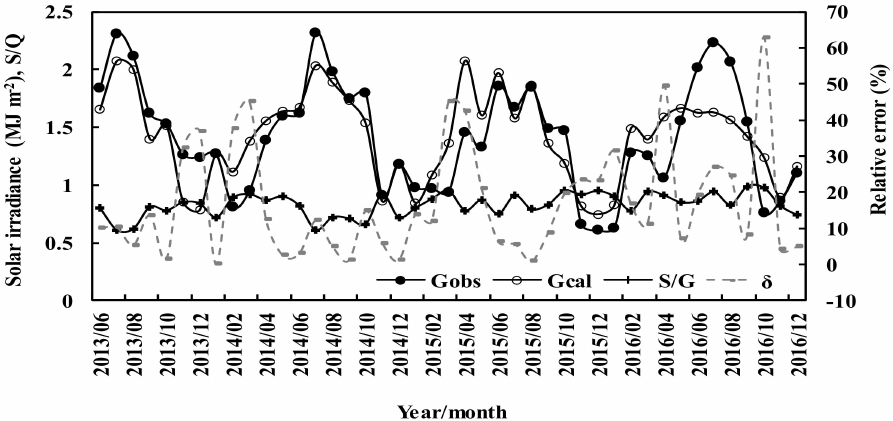
Figure 4. Calculated and observed global solar irradiances (G cal and G obs ) and their relative error ( δ ), and S/G from June 2013 to December 2016.